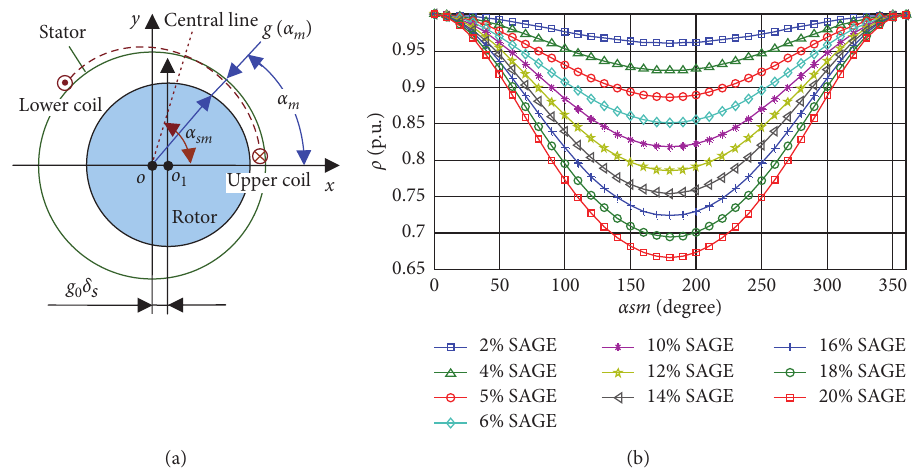
Figure 3: Impact of short circuit position on PPUA: (a) diagram to show the short circuit position; (b) relation of ρ vs. α